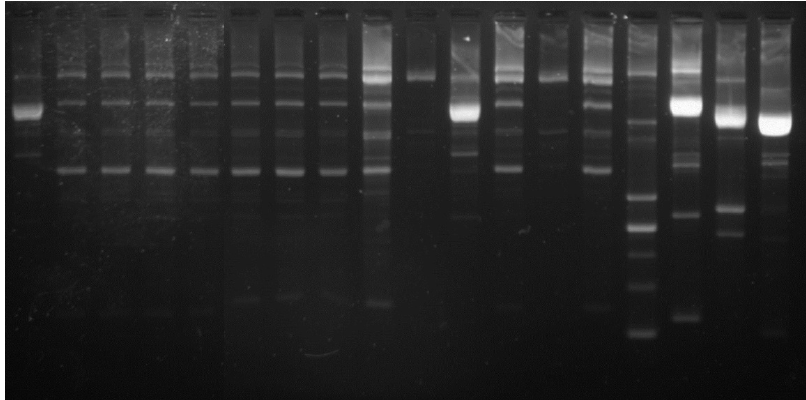
Figure 5. The rep-PCR profile of lactic acid bacteria (LAB) strains obtained after in vitro tests through GIS1 system as a measure of the impact of curcuma extracts. 1–14 new LAB strains, 15- L. acidophilus ATCC 314; 16- L. plantarum ATCC 8014, 17- Lc. lactis subsp. lactis DSM 20729, and 18- E. faecalis ATCC 51299 (from left to right).